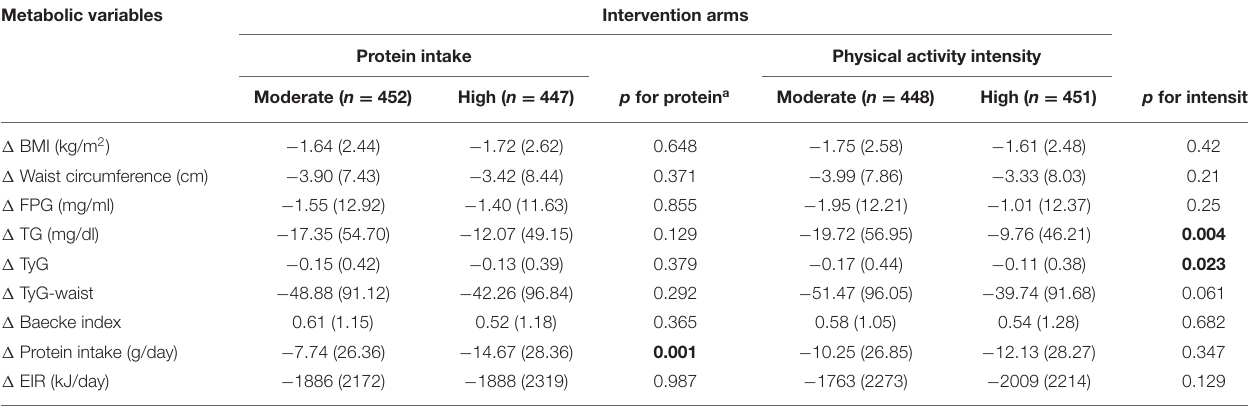
TABLE 2 | Change in anthropometrical and biochemical variables during the PREVIEW intervention between baseline and after 36-months of intervention (CID7), categorized by intervention arm. Metabolic